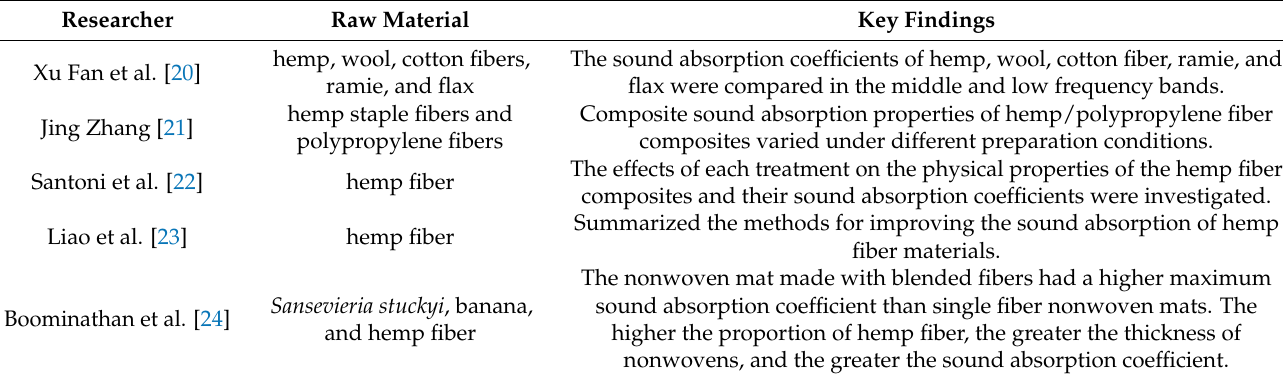
Table 1. A summary of studies of hemp fiber sound